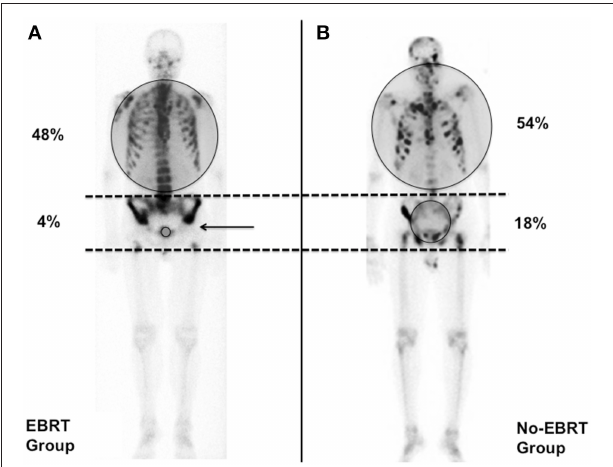
FIGURE 1 | Pattern of occurence of bone metastases > 5 in the external beam radiation therapy (EBRT) and No-EBRT-groups. Gray circles indicate the proportion of bone metastases > 5 inside and outside the pelvis. (A) Bone scan from a patient in the EBRT group who developed multimetastatic disease outside the pelvis. The pelvis is defined as the bone anatomy between the 2 dotted lines. The black arrow shows the limit of the prostate or prostate bed radiation (PPBR) field. There is a clear decrease of the bone uptake in-field. (B) Bone scan from a patient in the No-EBRT group. This man developed a multimetastatic disease including the